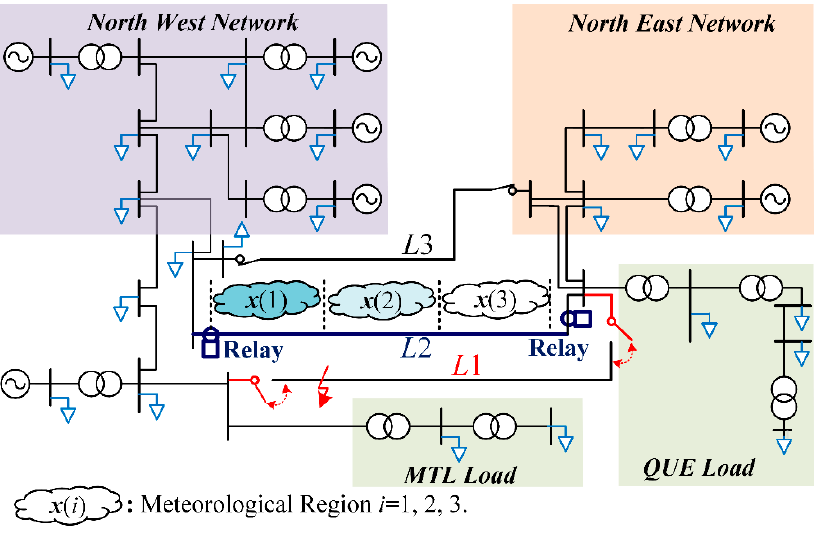
Figure 12. Modified 29-bus test system.